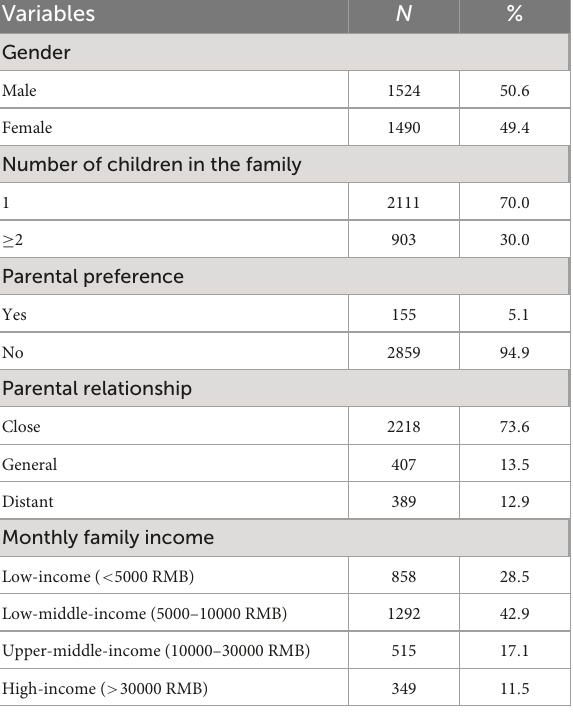
TABLE 3 Ordinal multiclass logistic regression analysis for the relationship between SSFD subscale and depressive symptoms.